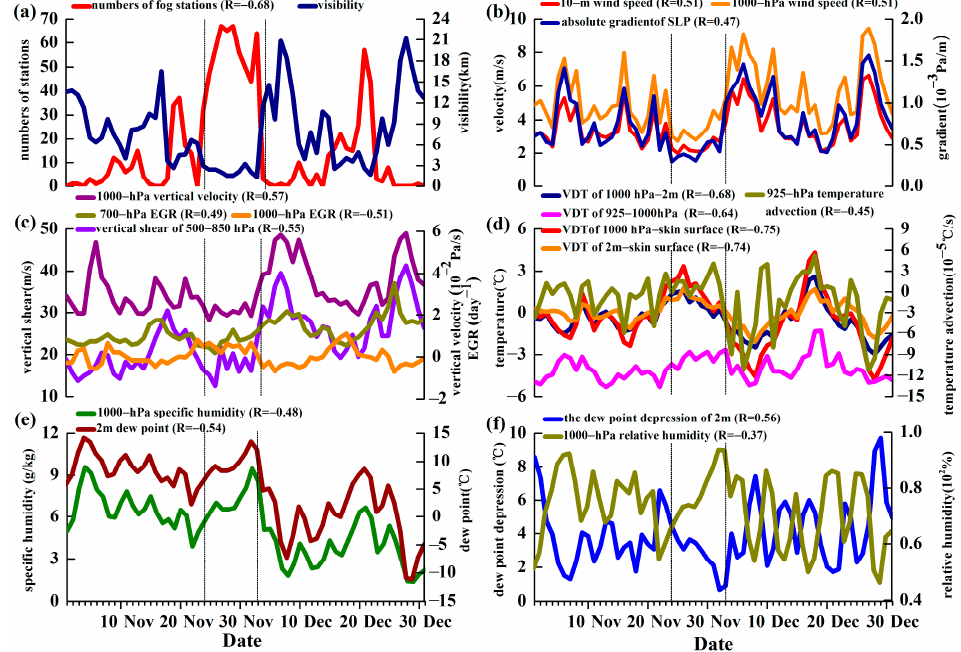
Figure 4. ( a )The daily evolution of the number of stations with the occurrence of fog and the daily averaged visibility over Jiangsu Province in China (The boundary of is Jiangsu Province marked in Figure 2c) and ( b – f ) the daily evolution of different kinds of related meteorological factors. All variabilities are averaged over the area of 115 ◦ E~122 ◦ E, 30 ◦ N~35 ◦ N. The parameters include (1) dynamical conditions ( b , c ): 10 m and 1000 hPa wind speed (units: m · s − 1 ), absolute gradient of SLP (units: 10 − 3 Pa · m − 1 ) ( b ), 1000 hPa vertical velocity (units: 10 − 2 Pa · s − 1 ), 700 and 1000 hPa EGR (units: day − 1 ), and vertical shear of winds between 500 and 850 hPa (units: m · s − 1 ) ( c ); (2) thermal conditions ( d ): vertical difference of temperature (VDT) between 1000 hPa and 2 m, between 925 and 1000 hPa, between 1000 hPa and the skin surface, and between 2 m and the skin surface (units: ◦ C), and the 925 hPa temperature advection (units: 10 − 5 ◦ C · s − 1 ); (3) vapor conditions ( e ,f): 1000 hPa specific humidity (units: g · kg − 1 ), dew point of 2 m (units: ◦ C) ( e ), the dew point depression of 2 m (units: ◦ C) and 1000 hPa relative humidity (units: %) ( f ). All numbers in the brackets in the legend of each line-layers are the correlation coefficients of each meteorological factor with the averaged daily visibility over Jiangsu Province in China. The period between the two vertical lines is from 24 November to 3 December.